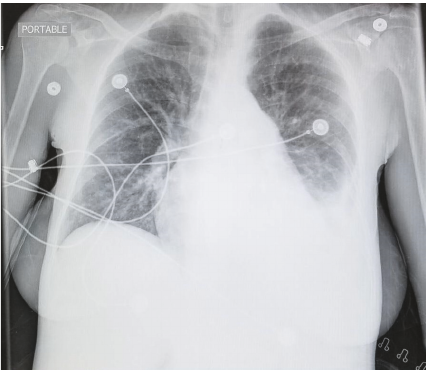
Figure 1: Initial chest X-ray demonstrating an isolated left-sided pleural effusion.